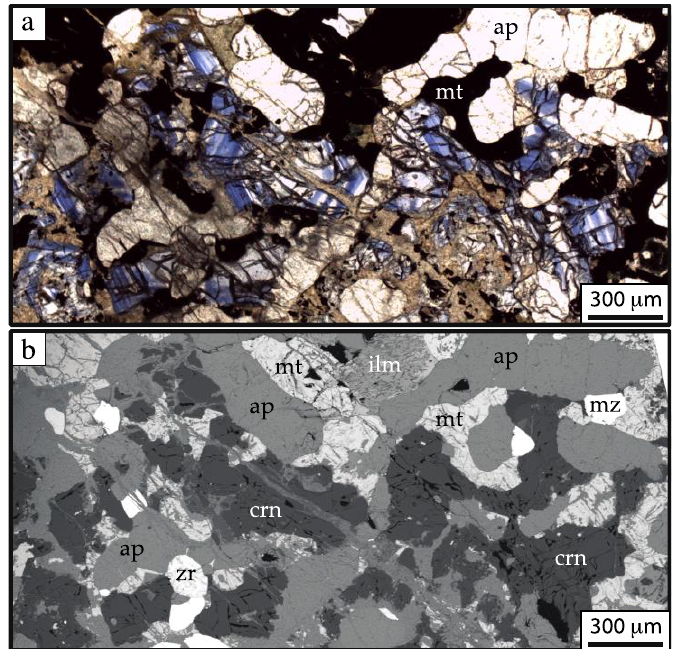
Figure 3. Low magnification images of sapphire-bearing nelsonite. ( a ) Photomicrograph of blue sapphire in plane-polarized light. ( b ) backscattered electron image of same area. Corundum (crn) is surrounding by grains of apatite (ap), magnetite (mt), ilmenite (ilm) being replaced by rutile and calcite, zircon (zr), and monazite (mz), and patches and fracture fillings of retrograde mixture of chlorite and biotite (brown in optical image). Note, hexagonal zoning in and void-filling texture of sapphire.